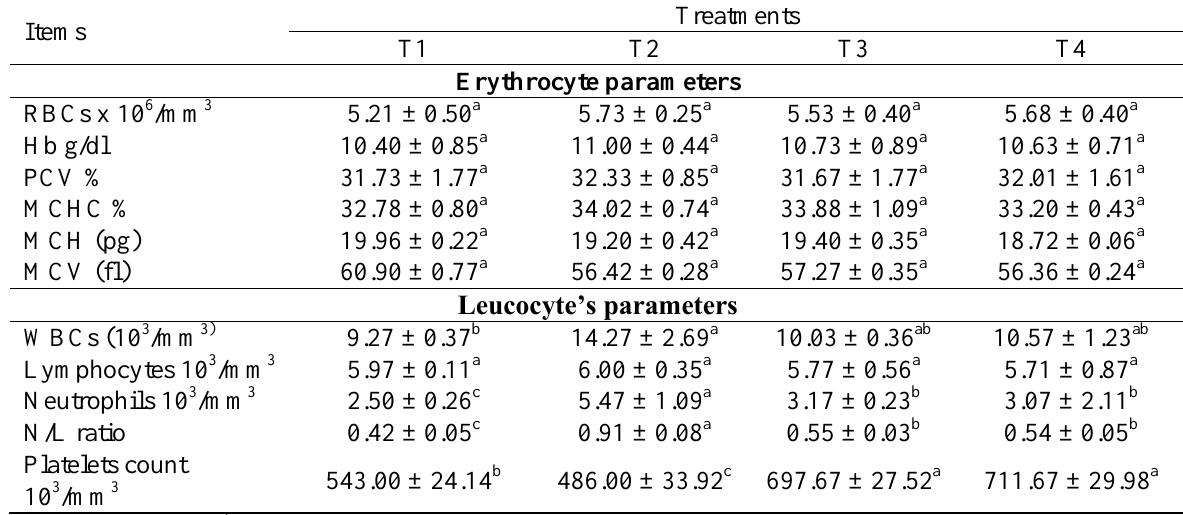
Table 4: The impact of aqueous extract of Eruca sativa leaves on hematological parameters of healthy and thioacetamide intoxicated mice (Mean ±